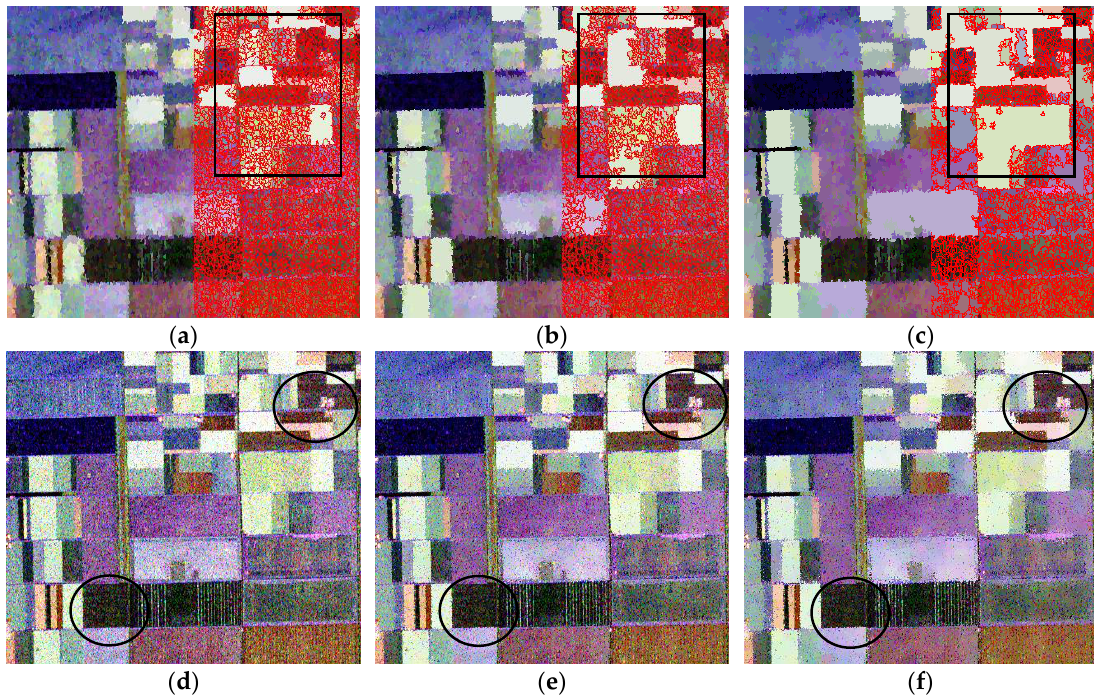
Figure 5. The segmentation [( a ) – ( c )] and filtering [( d ) – ( f )] results of the conventional mean shift algorithm with h s = 7, M = 10, and h r = 10 [(a),(d)], h r = 15 [( b ),( e )], and h r = 20 [( c ),(f)].